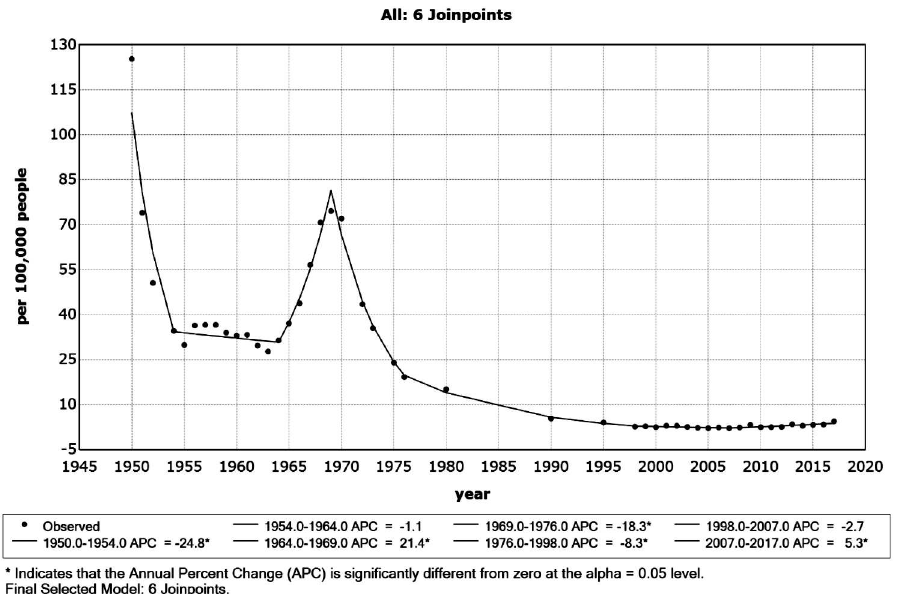
Figure 1. Incidence rates together with a fitted line for the six-joinpoits model